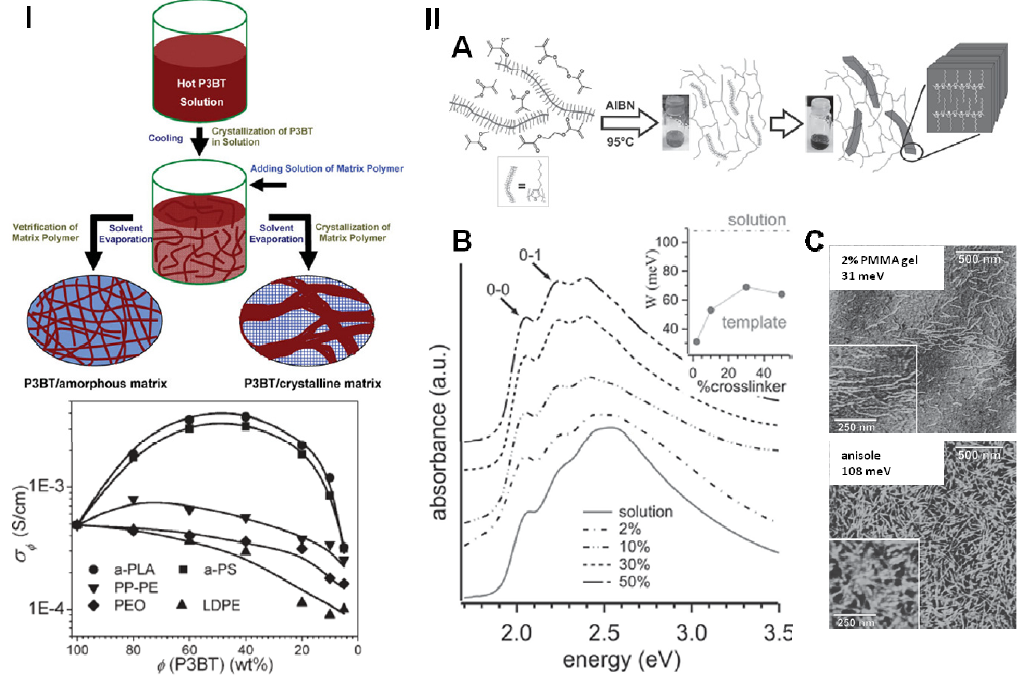
Figure 22. ( I ) Schematic illustration of the morphology evolution of P3BT/insulating polymer composites prepared from solution, employing amorphous and crystalline matrix polymers, respectively and the dependence of electrical conductivity σ of P3BT composites on P3BT content at room temperature, (Adapted with permission from [160]. Copyright 2010 Wiley-VCH Verlag); ( II ) The schematic illustrations of preparation of P3HT nanocrystals in a PMMA gel in ( A ); UV-Vis absorption spectra of P3HT nanocrystals in anisole solution ( solid line ) and in PMMA gels at different crosslinker content with the inset showing the calculated exciton bandwidth ( W ) in ( B ); and the tapping-mode AFM phase micrographs showing P3HT aggregates formed in PMMA2 or in anisole solution in ( C ), (Adapted with permission from [161]. Copyright 2012 Wiley-VCH